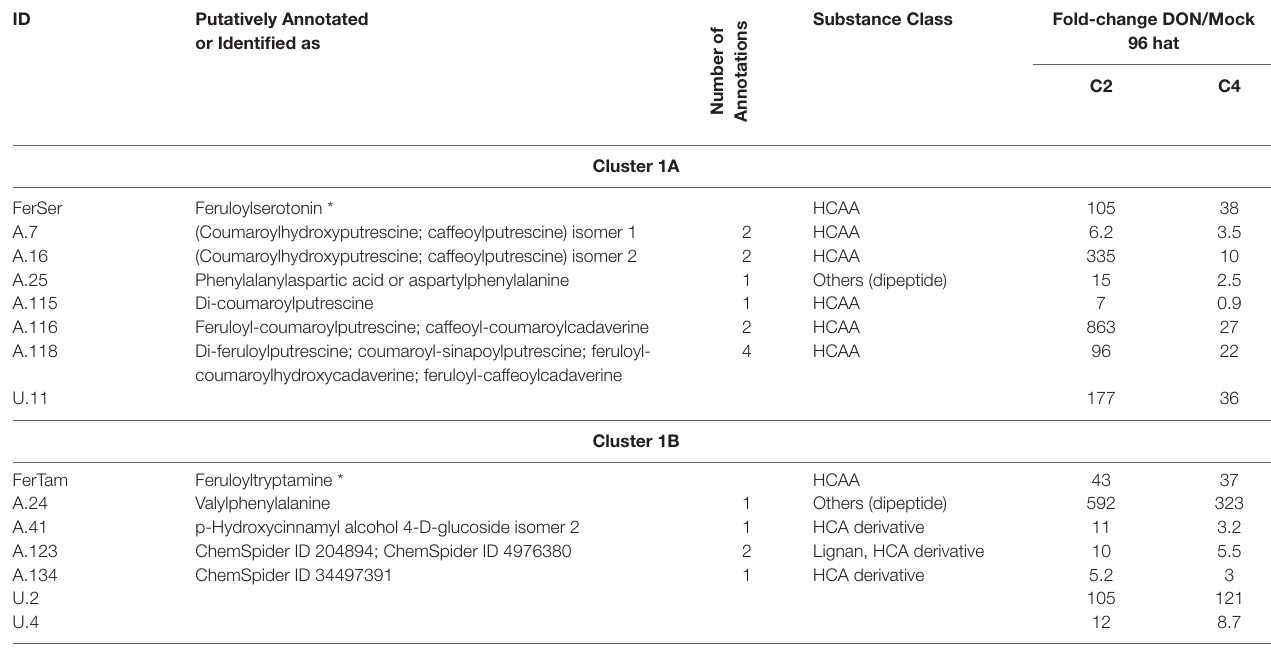
TABLE 1 | Metabolites assigned to cluster 1 of the time course profile